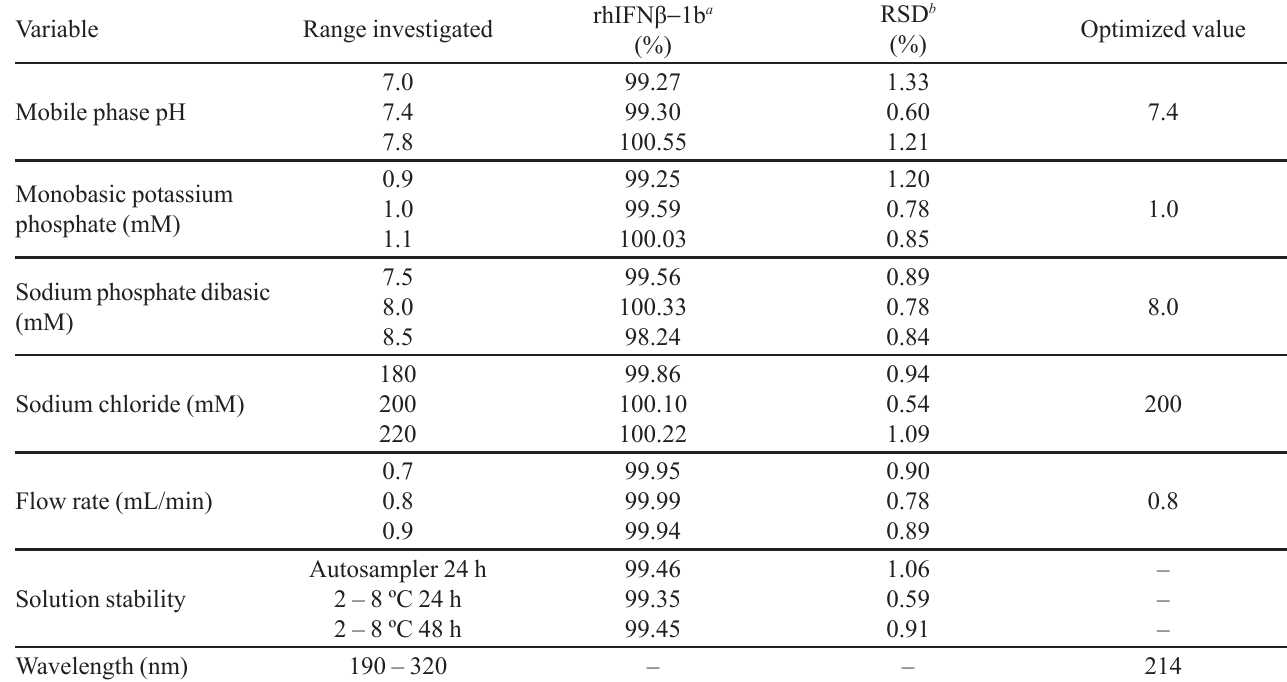
TABLE III - Chromatographic conditions and range investigated during robustness test for the SE-LC method Variable